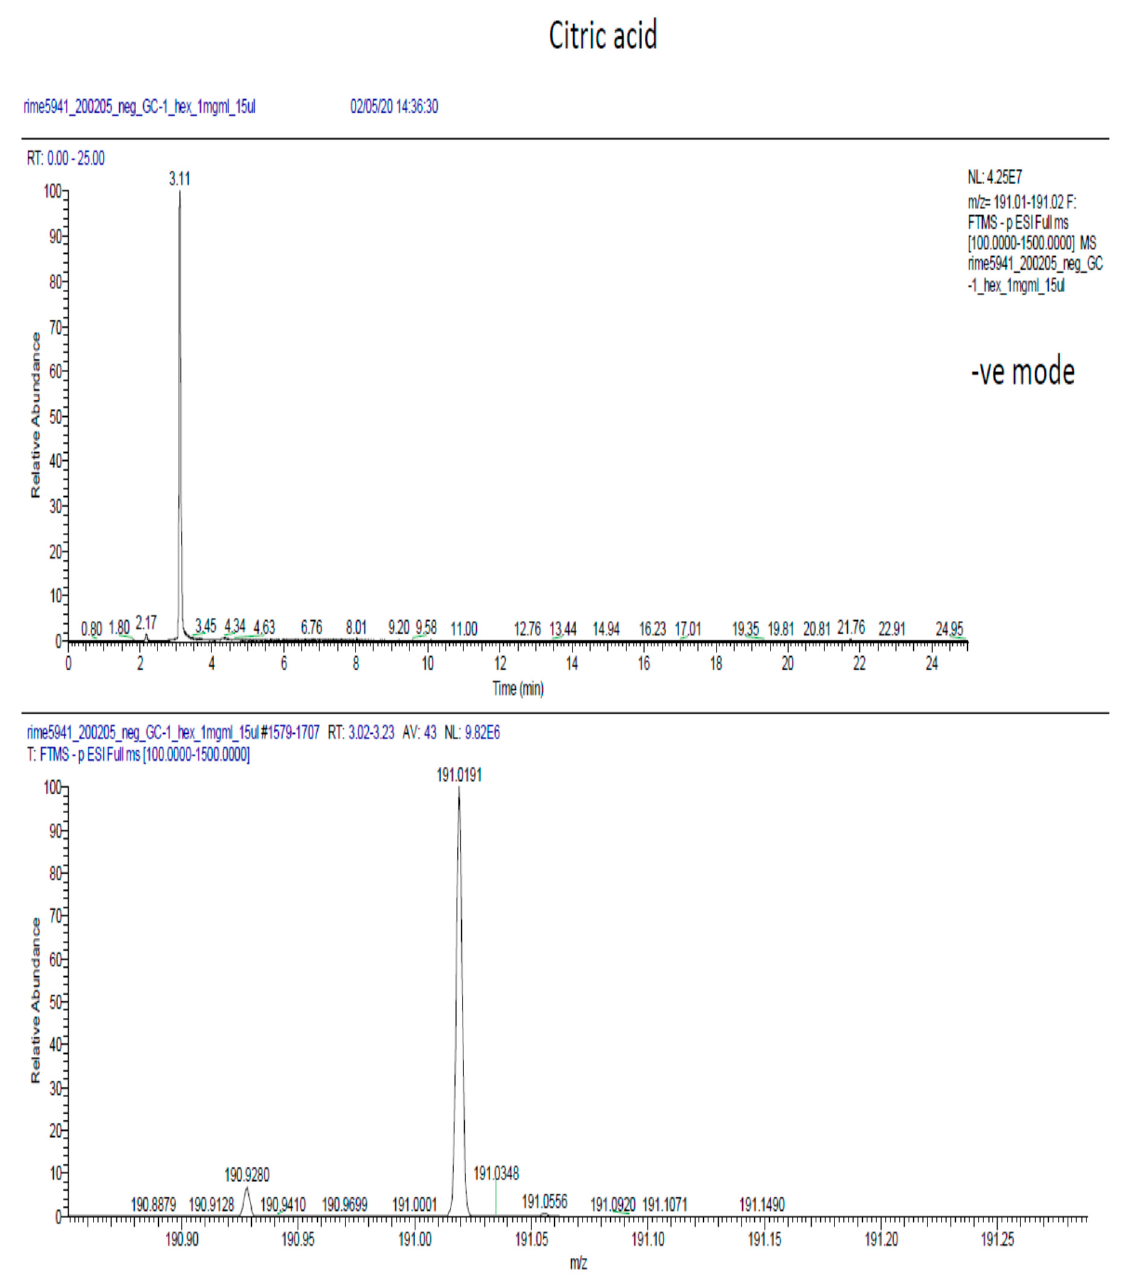
Figure A4. UPLC-MS analysis of the n -hexane extract of G. cambogia indicating the presence of citric acid.